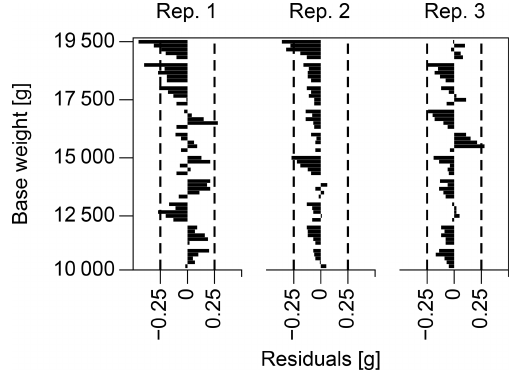
Figure 3. Residuals of three replications (Reps. 1 to 3) with relative mass changes of